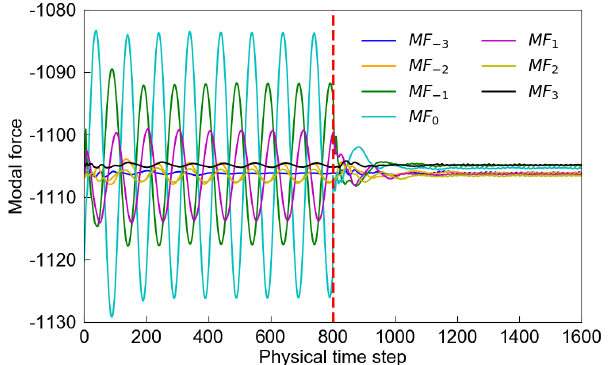
Figure 10. Modal force convergence